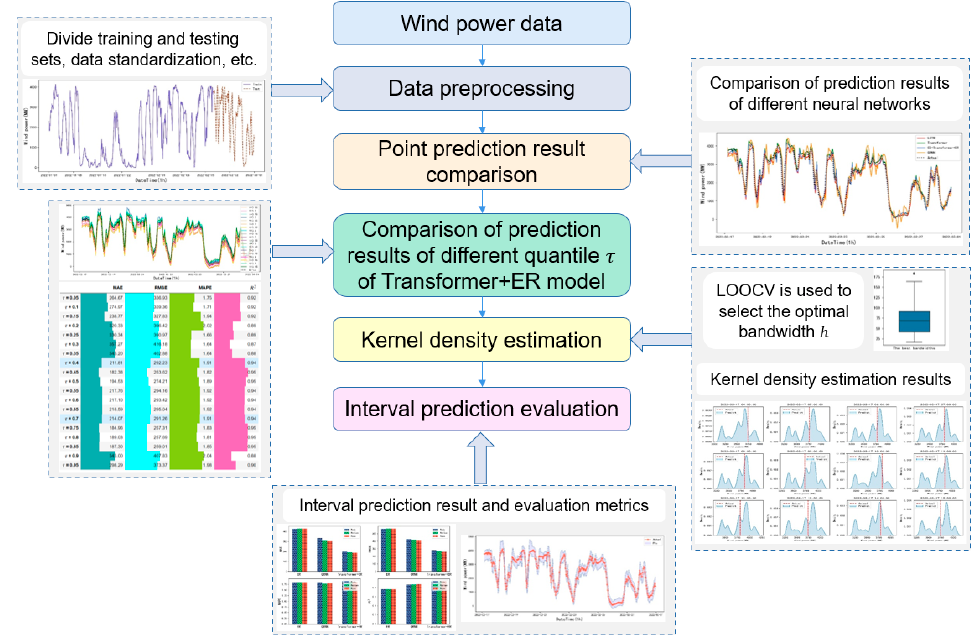
Figure 4. The framework of the overall WPF.